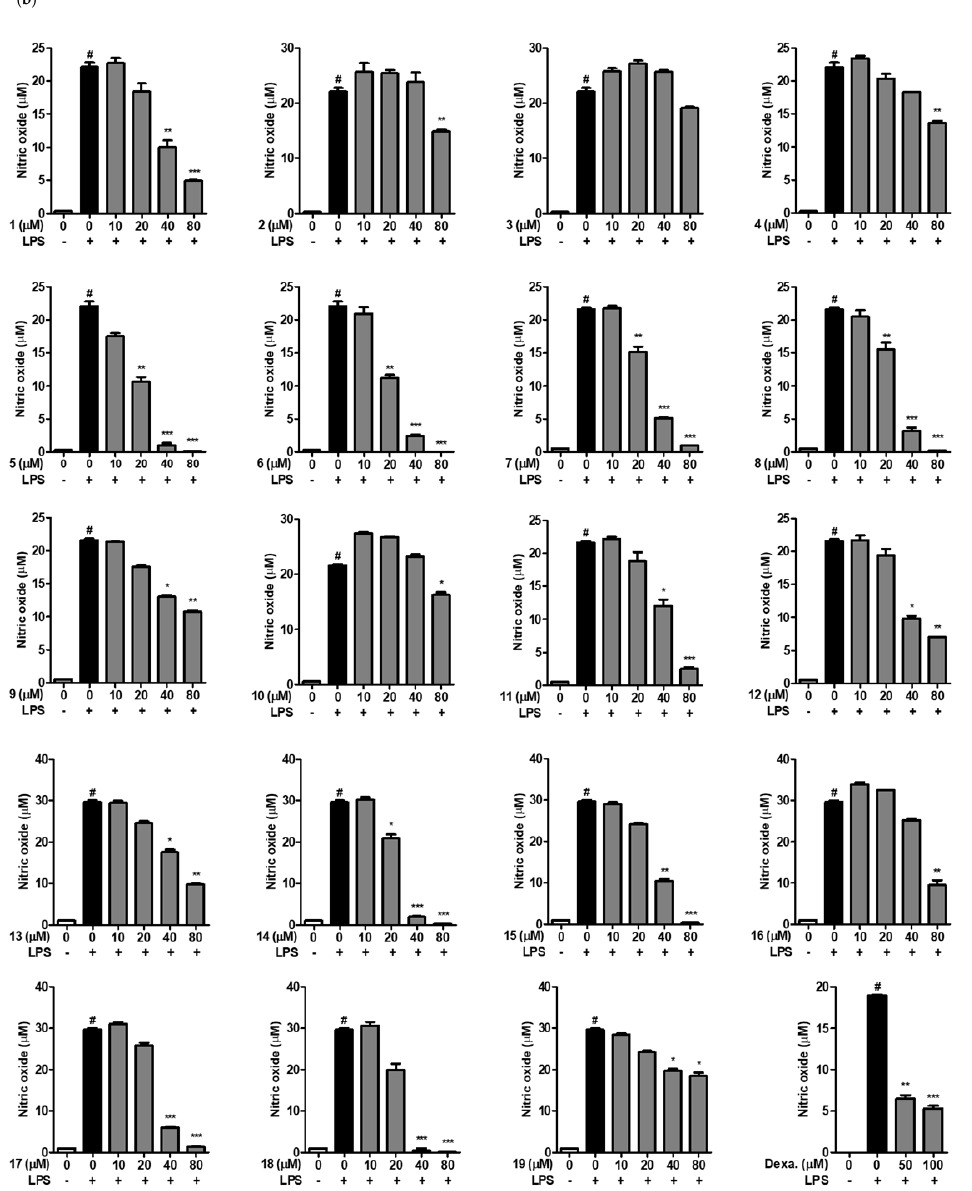
Figure 4. Effects of nineteen 3-substituted-indolin-2-one derivatives on cytotoxicity and nitric oxide production in lipopolysaccharide (LPS)-stimulated RAW264.7 cells; (-): non-treated group, (+): LPS- treated group. ( a ) RAW264.7 cells (1 × 10 5 /well, 96-well plates) treated with nineteen 3-substituted- indolin-2-one derivatives for 2 h and incubated with LPS for 18 h. Cytotoxicity measured by EZ- cytox cell viability solution as described in the Materials and Methods section; ( b ) RAW264.7 cells (1 × 10 5 /well, 96-well plates) treated with 3-substituted-indolin-2-one derivatives at varying con- centrations (10, 20, 40, and 80 µ M) for 2 h, and then stimulated with LPS (500 ng/mL) for 18 h. Cell supernatants were collected, and nitric oxide concentration was determined using Griess reagents as described in the Materials and Methods. White bar: non-treated group, black bar: LPS treated group, gray bar: sample treated group. # p < 0.0001 vs. the control group. *** p < 0.0001, ** p < 0.001 or * p < 0.05 vs. the LPS